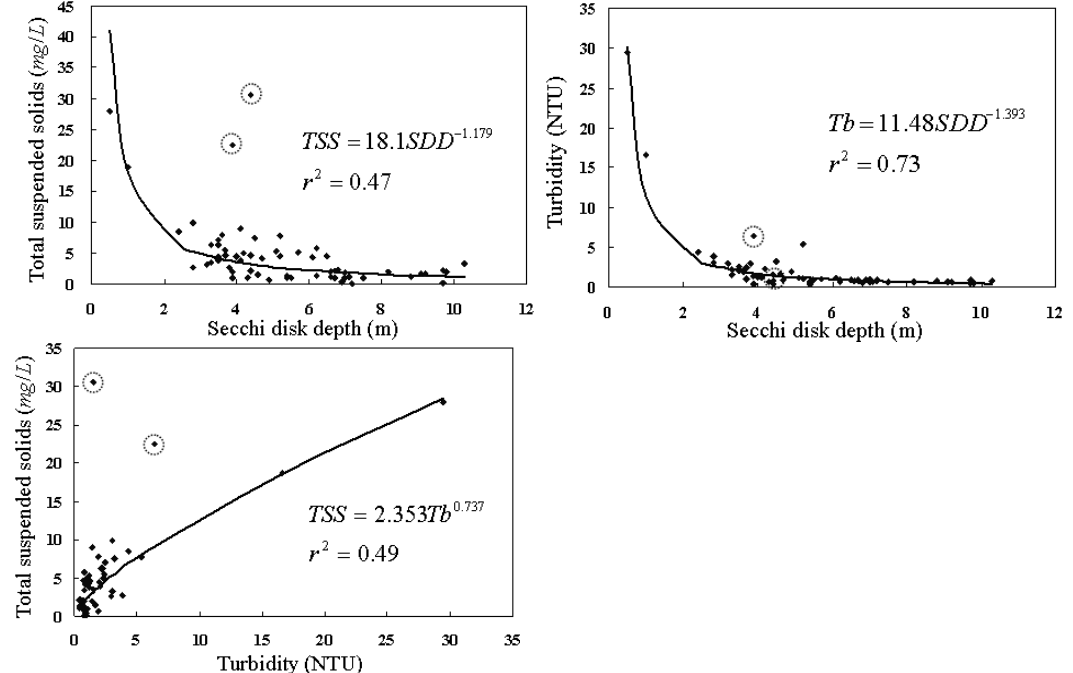
Figure 4. Empirical relationships among different water quality parameters. Points marked by dashed-circles are not included in regression modeling and are excluded from the subsequent